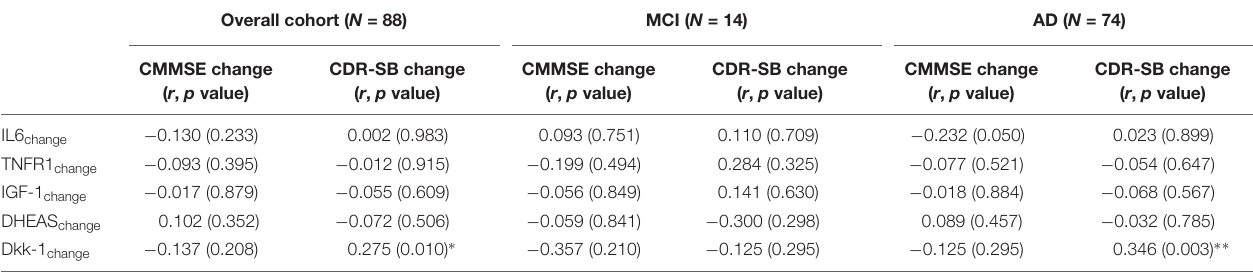
TABLE 3 | Correlation between changes in blood biomarkers and cognitive performance.